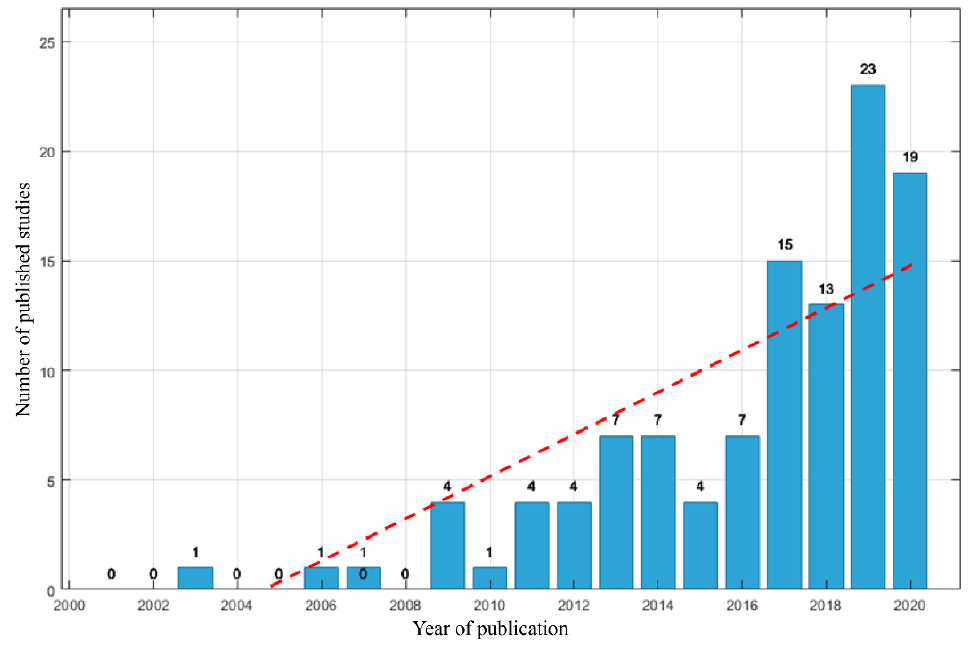
Figure 2. Annual trends of the published literature regarding studies’ investigations of SUHI/LULC